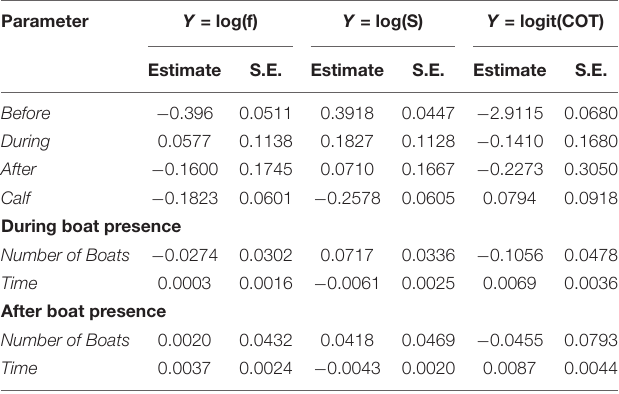
TABLE 2 | Estimated coefficients and standard error (S.E.), for each of the parameters of the models developed for breath frequency ( f ), swimming speed (S), and mass-specific cost of transport (COT).